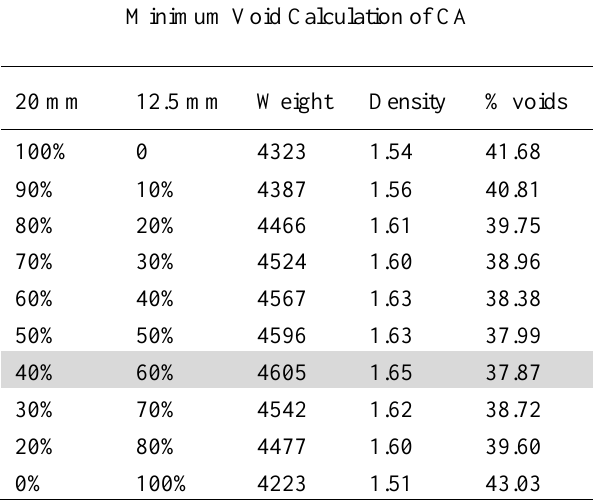
Percentage void observation for coarse